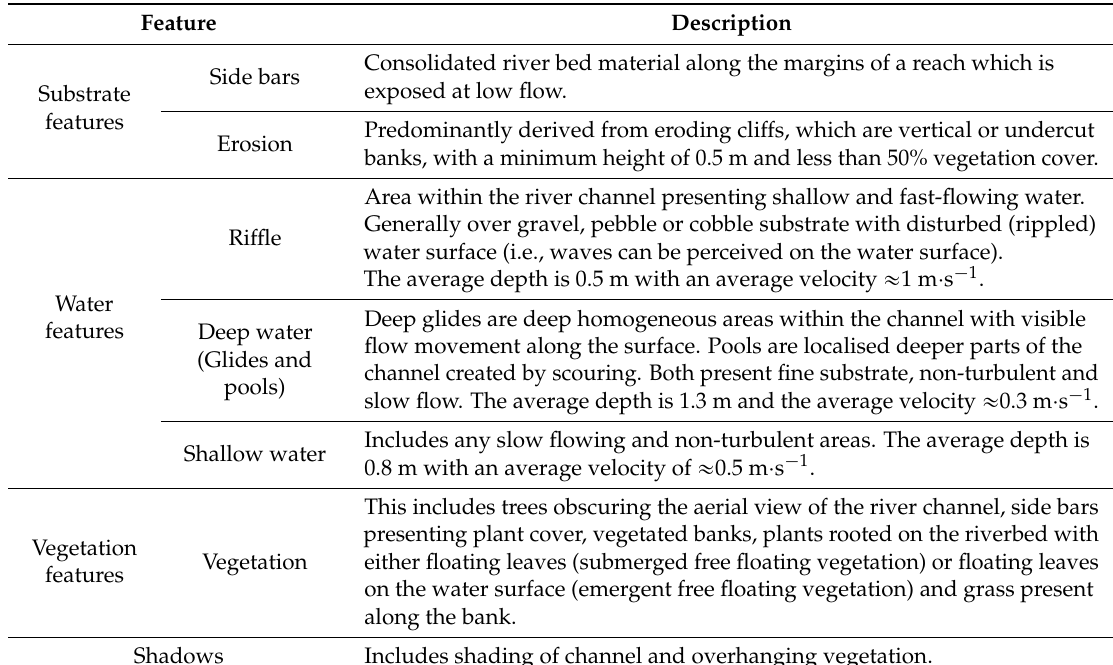
Table 1. Hydromorphological features identified within the study area in the river Dee, near Bala, UK based on